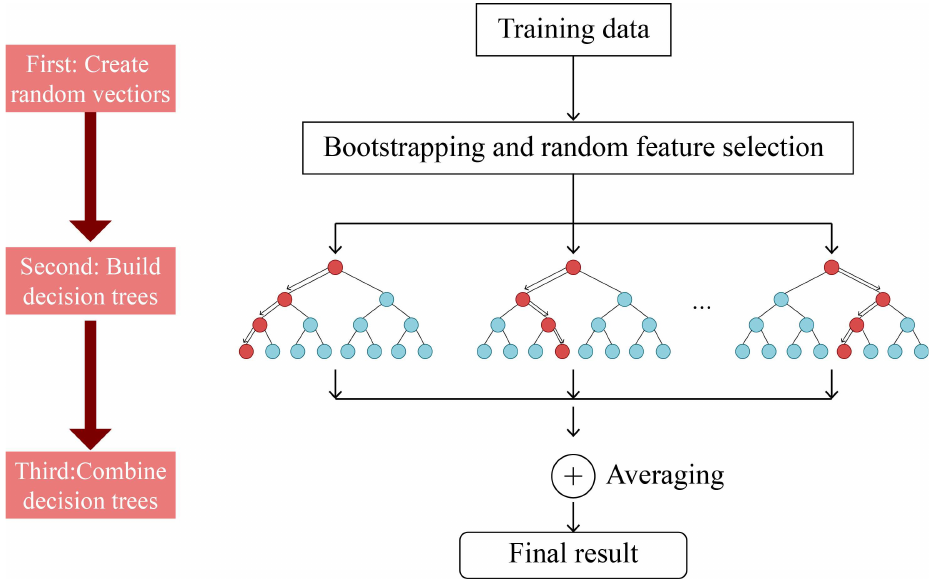
Figure 3. Working route of random forest algorithm.